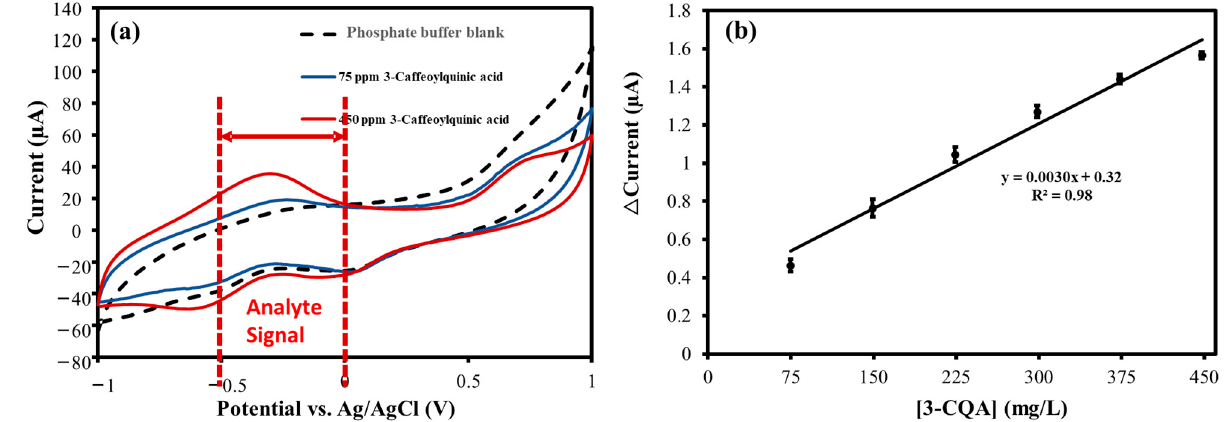
Figure 7. ( a ) Overlaid CVs obtained from the analysis of 0.10 M phosphate buffer blank, 75, and 450 mg/L 3-caffeoylquinic acid (3-CQA) (in 0.10 M phosphate buffer) taken using the PANI@CNT/CNC SPME MN. ( b ) Associated 3-CQA concentration vs. △ Current linear plot determined by averaging the 3-CQA oxidation peak current signal in the − 0.5 V–0.0 V.